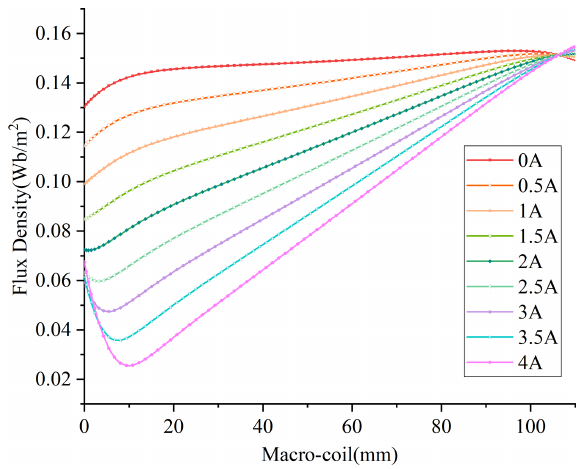
Figure 8. The magnetic flux density value at the working air gap.